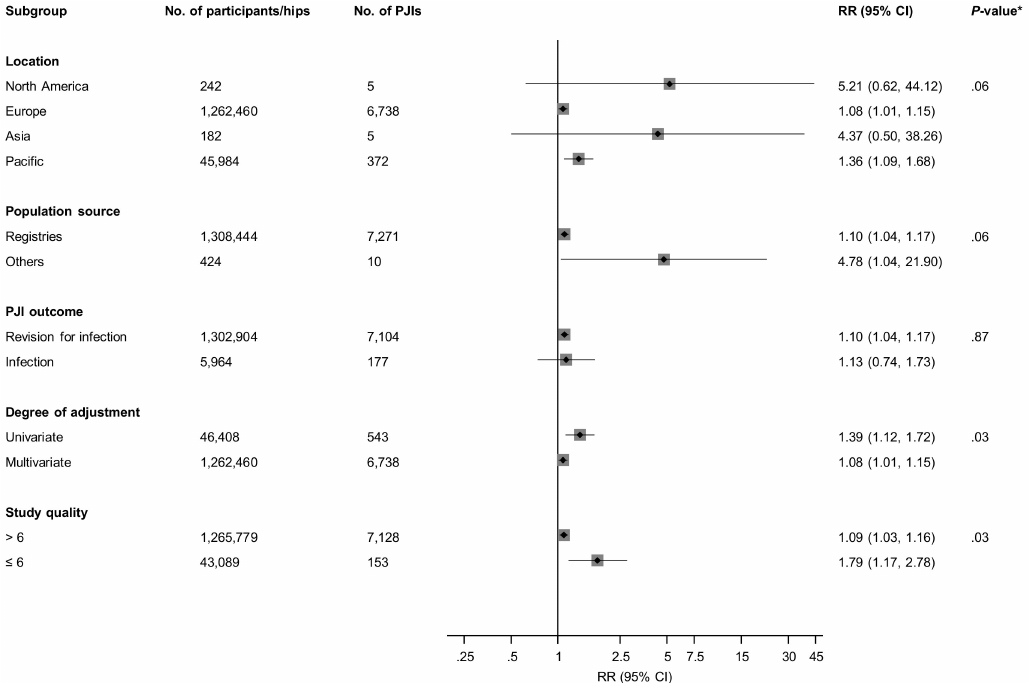
Figure 3. Comparison of all cemented fixation with uncemented fixation and the risk of prosthetic joint infection in observational studies, grouped according to several study characteristics. CI, confidence interval (bars); PJI, prosthetic joint infection; and RR, relative